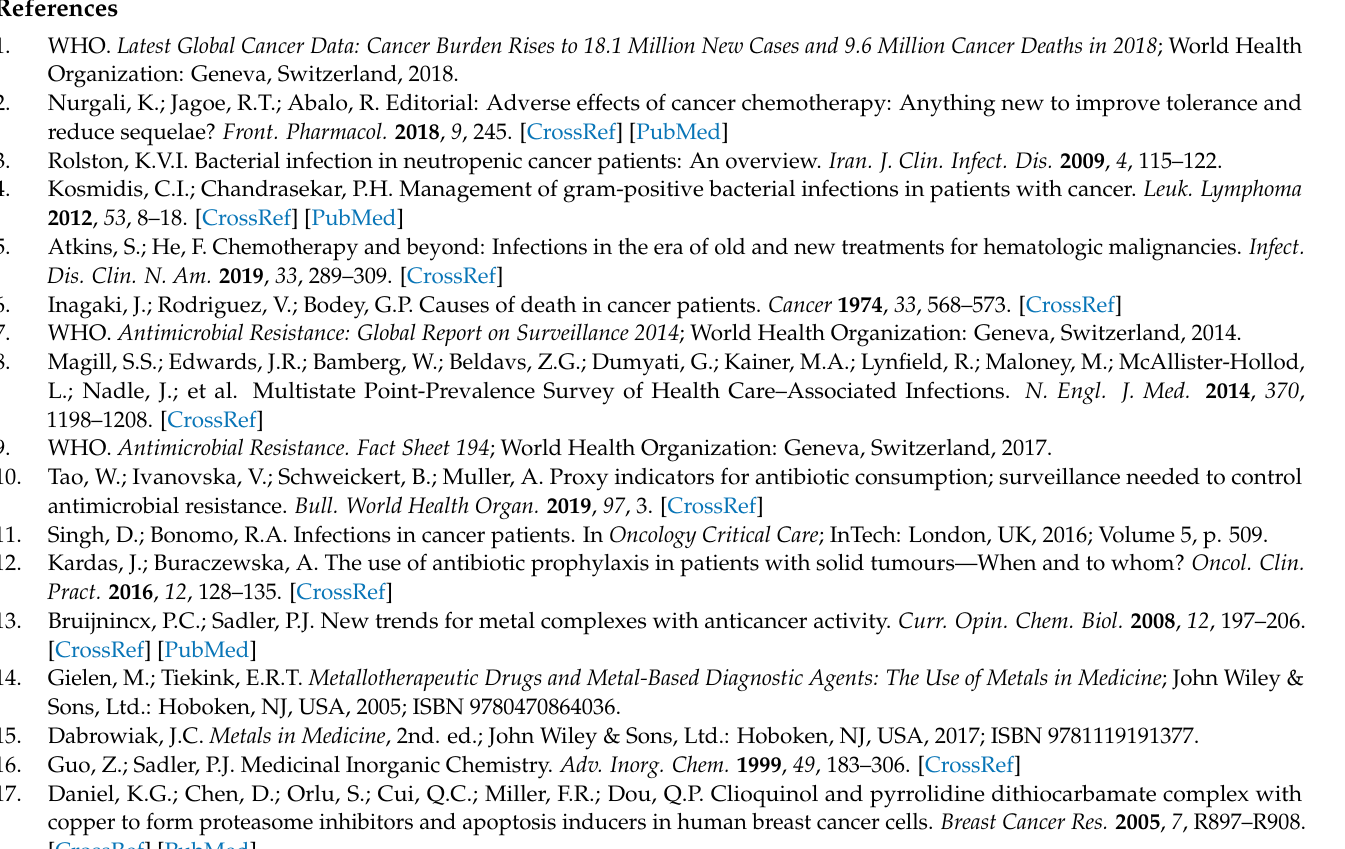
(c), Figure S8: Ribbon representation of the Hsp70 protein with bound compounds H L0 (a), cis - [Cu( L0 ) 2 ] (b), trans -[Cu( L0 ) 2 ]